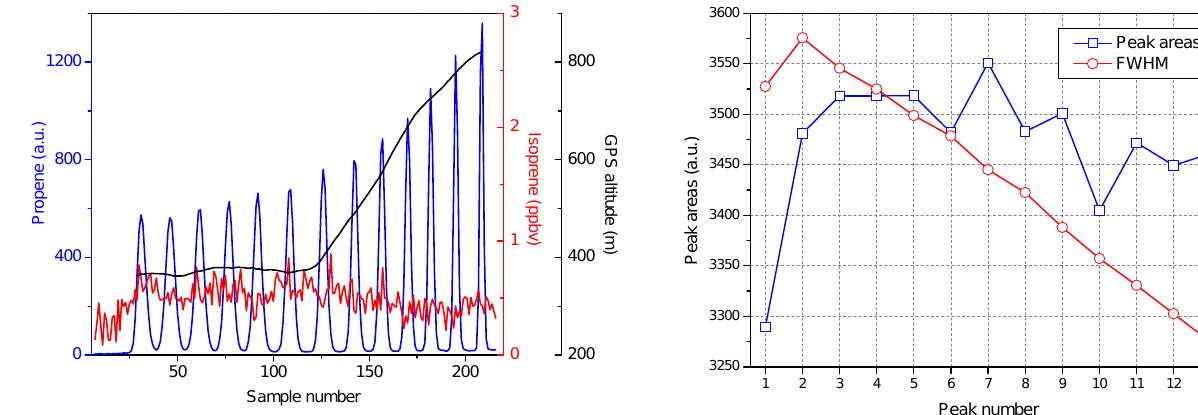
Fig. 8. The concurrent mixing ratio of isoprene with the count rate of propene. The GPS altitude is interpolated based on the peak posi- tion of propene. Data shown here are for flight 4 during the PINOT- NOIR campaign. See text for detailed explanation.